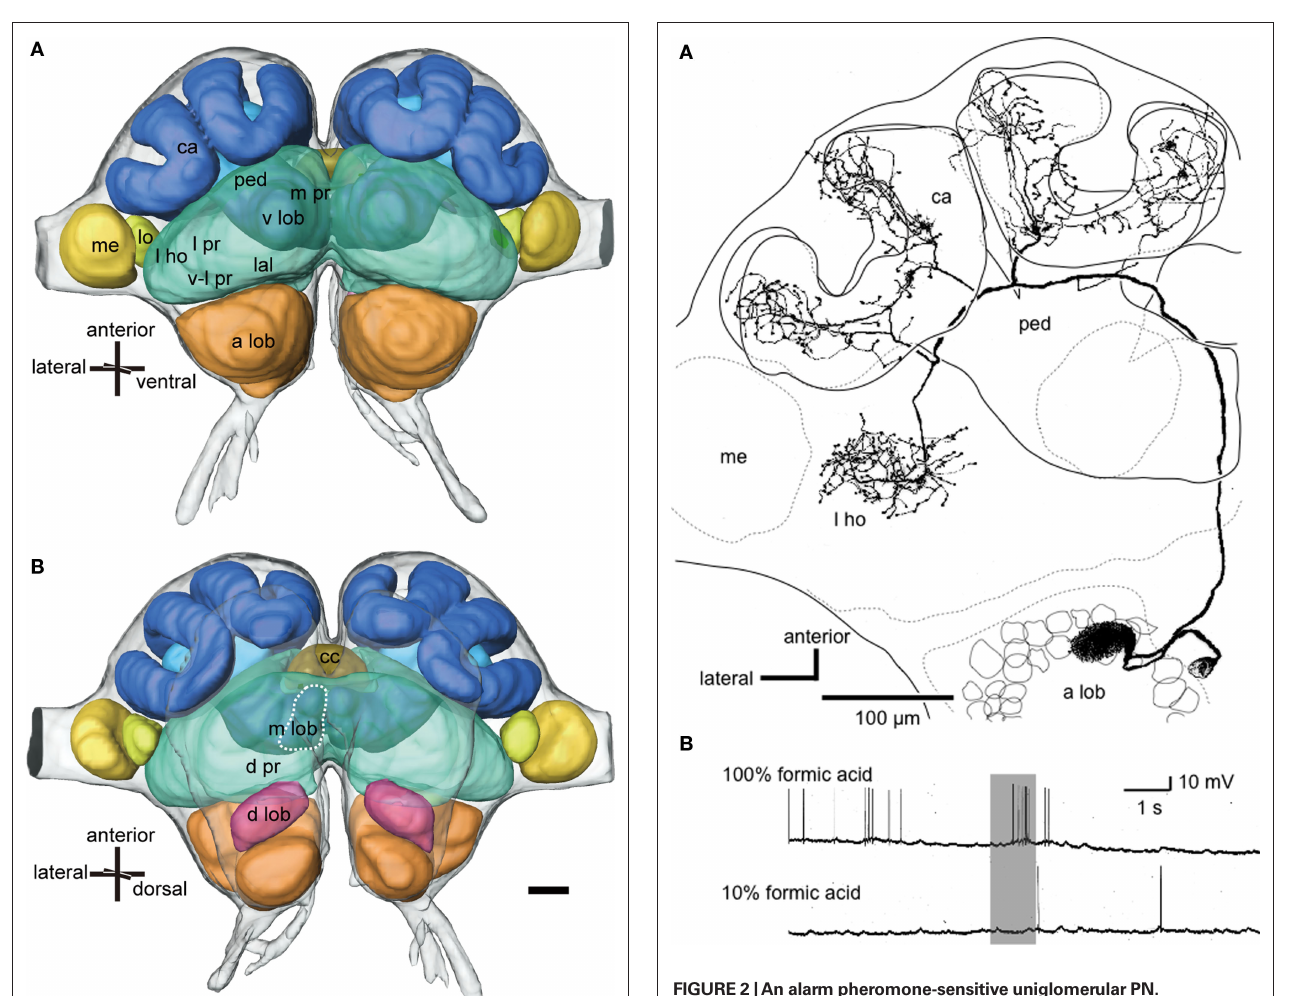
Figure 2 | An alarm pheromone-sensitive uniglomerular PN. (A) Reconstruction of an alarm pheromone-sensitive PN from confocal sections viewed ventrally. The soma is located at the medial cell cluster of the deutocerebrum. The dendritic arbors cover the AS1 glomerulus in the antennal lobe (a lob). The axon ascends through the medial anteno-cerebral tract and terminates in the lip region of the calyces (ca) and the lateral horn (l ho). me: medulla, ped: pedunculus. (B) Responses of the PN to formic acid. 10% formic acid indicates that it was diluted to 1/10 by distilled water. Modified from Yamagata et al.